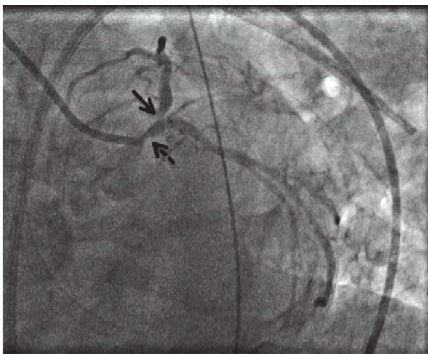
Figure 1: Left heart catheterization demonstrating left main disease (dashed) and 70% LAD ostial lesion (solid).